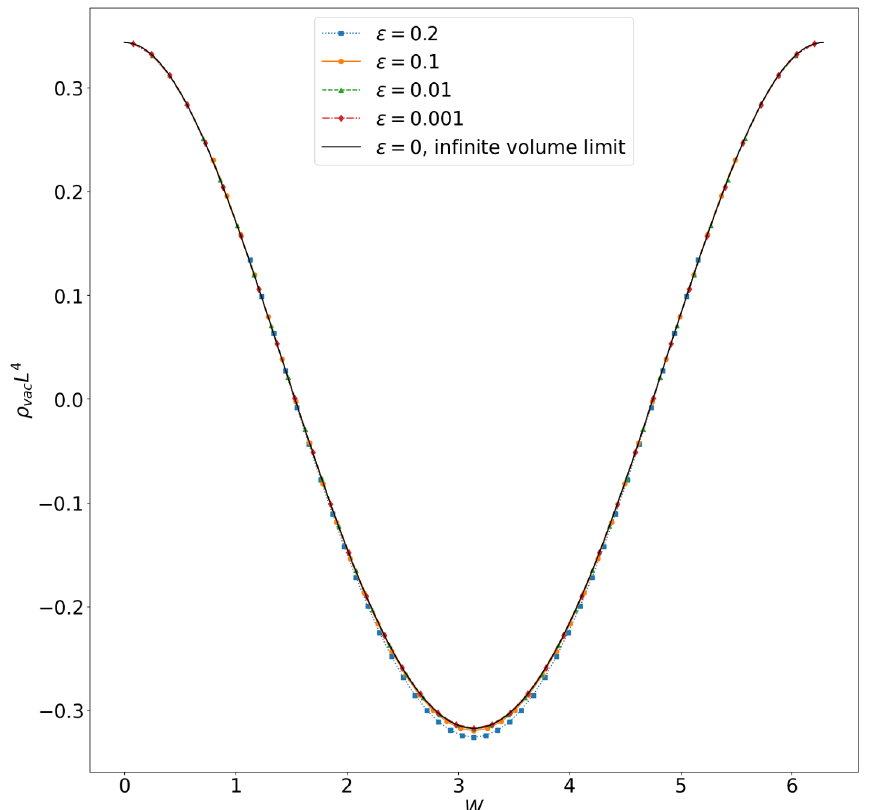
Figure 3 . The contributions of a single massive fermion (with mass M ∼ 1 /L ) to the GPY potential. The numerical evaluation used N = 100000 and N = 500 as the upper limit for the n - and p -sums n p in equation (4.11). Here there are no issues with convergence, as for the Taylor series required for the n = − 1 modes of the boson. The infinite volume limit was calculated from equation (4.21) with upper limit N = 500 m